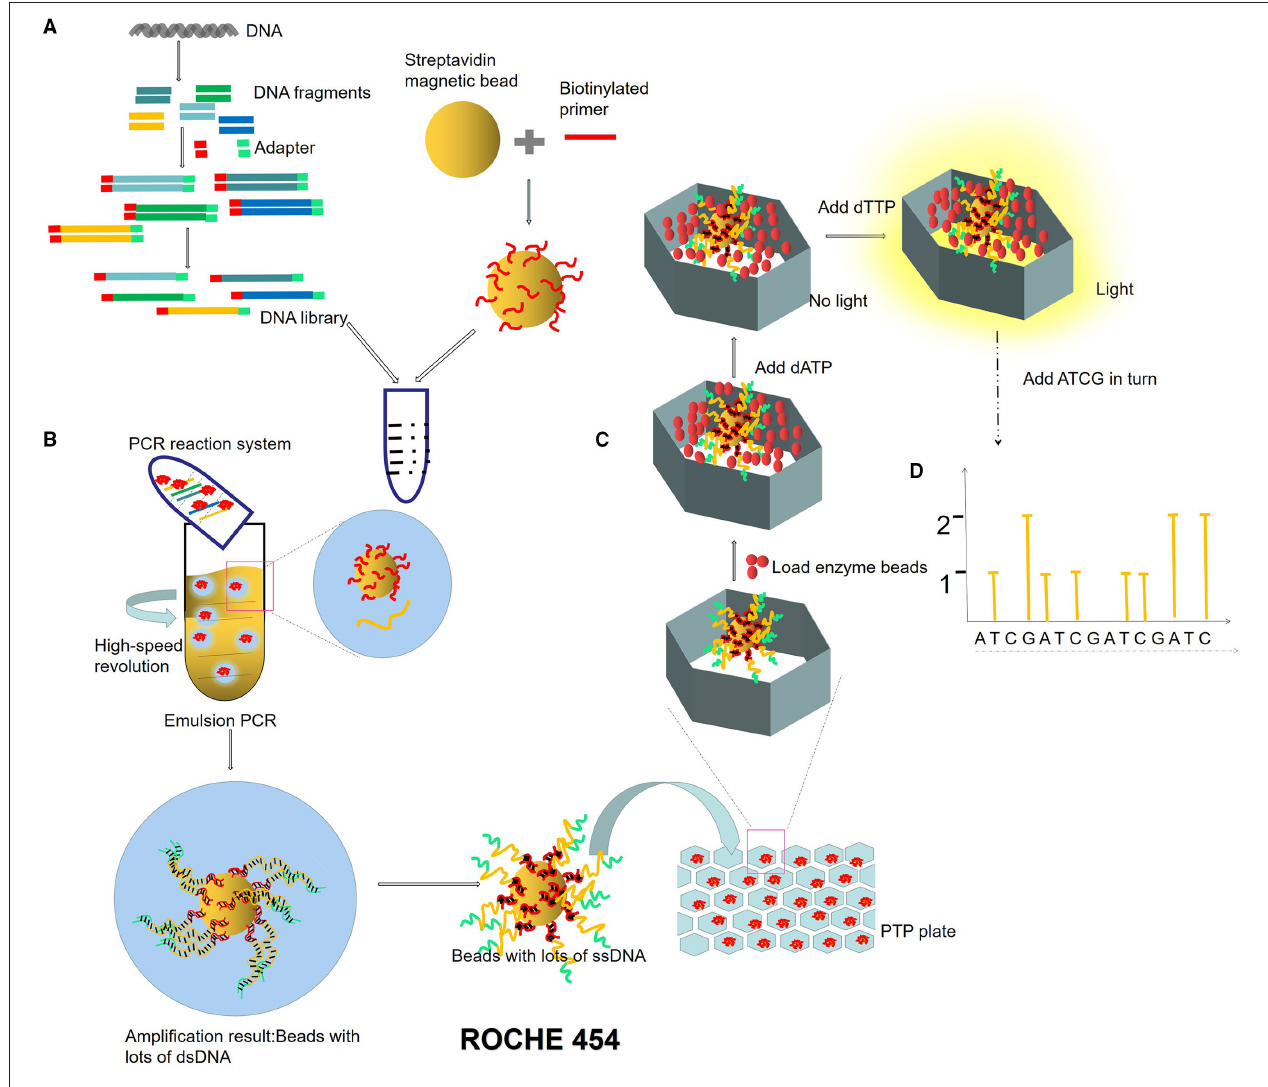
FIGURE 2 | ROCHE 454 sequencing process. (A) Construction of micro-reaction system. DNA library is constructed by adding an adapter at the ends of DNA fragments. The magnetic beads combined with primers are mixed in the PCR reaction system (DNA fragments, enzymes, dNTPs). (B) Emulsion PCR. PCR microreaction systems are formed by injecting water (PCR mixture) into the oil, and each system contained only one template and one bead. (C) Pyrophosphate sequencing. Pyrophosphate technology is an enzyme cascade chemiluminescence reaction in the same reaction system catalyzed by four enzymes. In each circle of the sequencing reaction, only one dNTP is added. If it just matches the next base of the DNA template, it will be added to the 3 ′ end of the sequencing primer under the action of DNA polymerase and release a molecular PPi at the same time. Under the action of ATP sulfurylase, luciferase, and apyrase, an enzyme cascade chemiluminescence reaction is triggered by the PPi. (D) Light signal